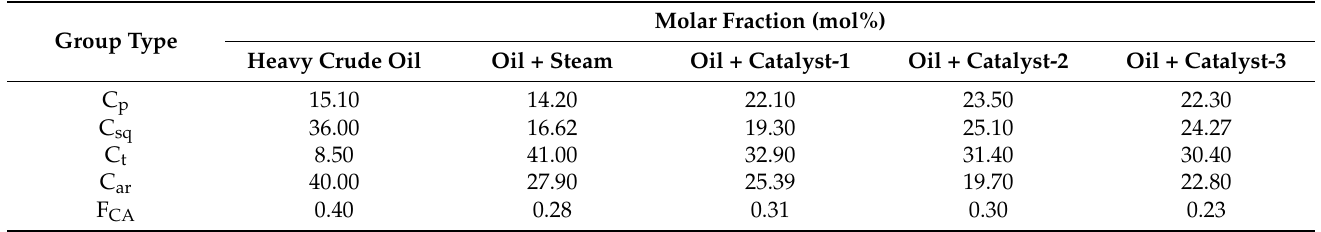
Table 9. Molar Fraction (%) of carbon groups of asphaltenes before and after the upgrading